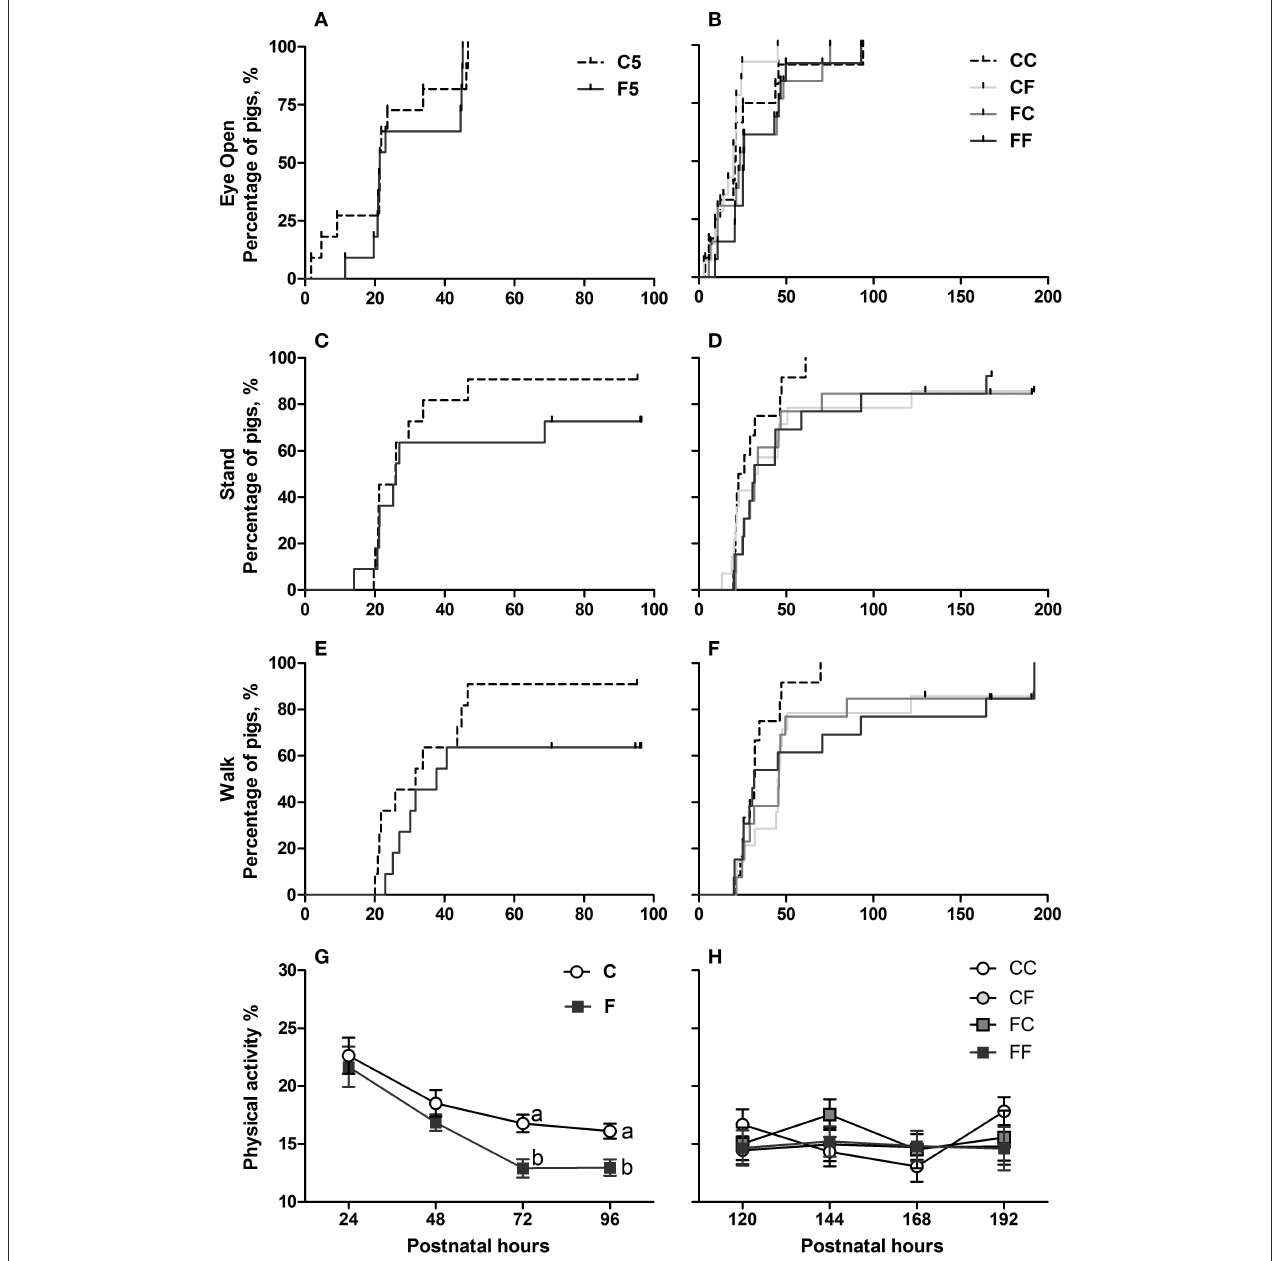
FIGURE 2 | Time to acquisition of basic motor skills and home cage activity. Kaplan–Meier plots of time to first eyelid opening (A,B) , first stand (C,D) , and first walk (E,F) expressed as percentage of pigs. Home cage activity percentage over postnatal hours 24–48 (G) and 120–192 (H) expressed as means ± SEM. Means marked with different letters on the same day are significantly different, P < 0.05. n = 11 for C5 and F5 groups, n = 37 each for C and F groups, and n = 12–14 for CC, CF, FC, and FF groups. C, colostrum feeding for the first 4 days; CC, colostrum feeding until day 9; CF, 4 days colostrum feeding followed by formula feeding until day 9; F, formula feeding for the first 4 days; FC, 4 days formula feeding followed by colostrum feeding until day 9; FF, formula feeding until day 9.